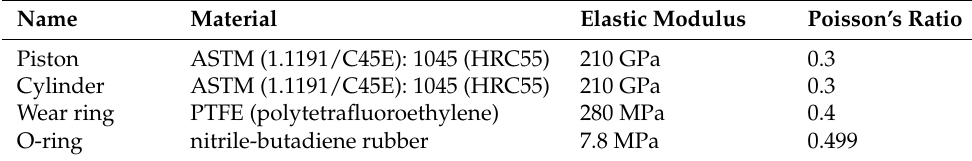
Table 1. Material table of the hydraulic cylinder and combined sealing ring.